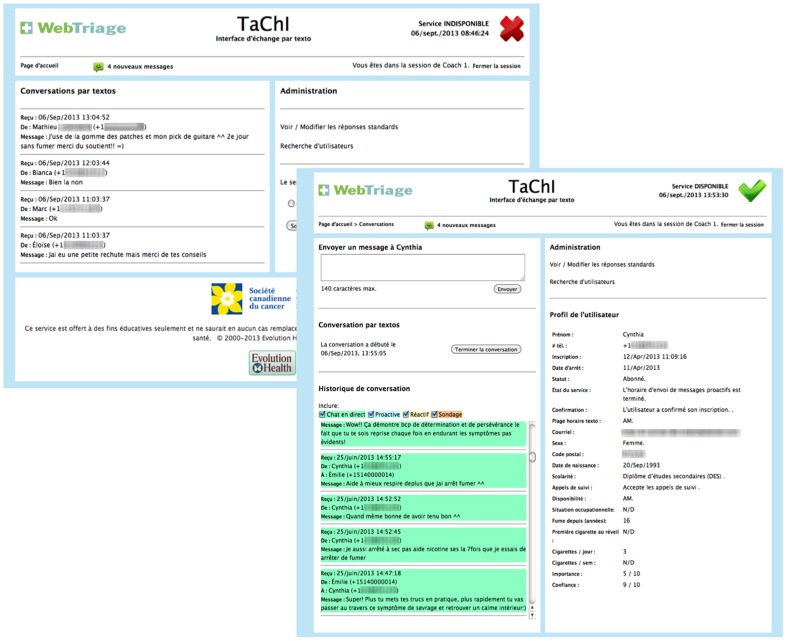
TaChI Interface.